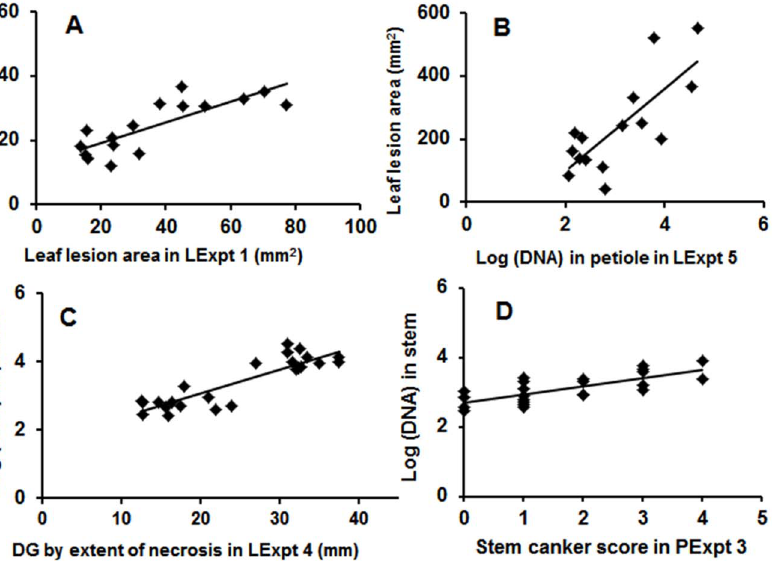
Figure 5. Relationships between different methods for assessment of quantitative resistance. Different methods were used to assess growth of Leptosphaeria maculans in leaf petioles or in stems of doubled haploid lines A30 (susceptible) or C119 (with quantitative resistance). Relationships between leaf lesion area and distance grown (DG) by L. maculans in the leaf petiole viewed by GFP in experiment LExpt 1 (A; R 2 =0.64) or amount of L. maculans DNA in leaf petiole in experiment LExpt 5 (B; R 2 =0.59); or between amount of L. maculans DNA and DG in leaf petiole viewed by extent of necrosis in experiment LExpt 4 (C; R 2 =0.78); or between amount of L. maculans DNA in the stem and stem canker severity score in experiment PExpt 3 (D; R 2 =0.56). The amount of L. maculans DNA in the petiole or stem was log 10 -transformed. Details of these experiments are presented in Table 1.